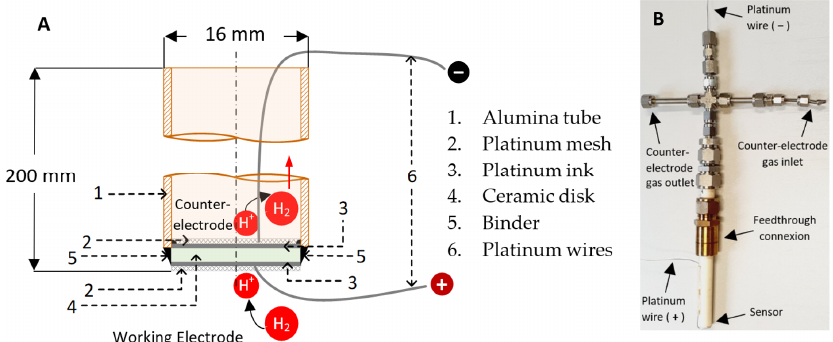
Figure 1. ( A ) Scheme showing the structure of the hydrogen sensor and ( B ) a picture of the sensor.